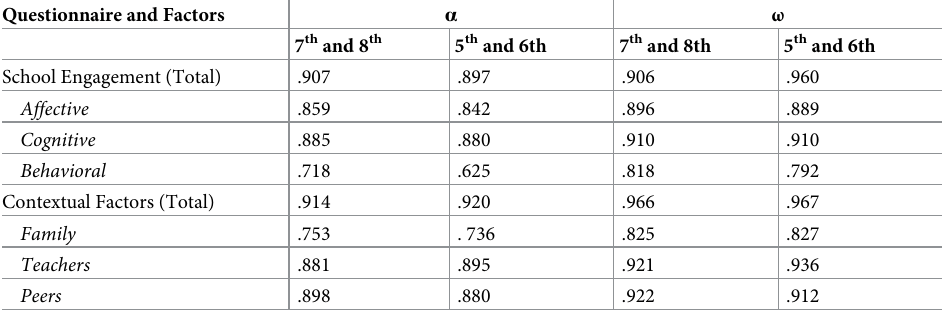
Table 3. Reliability of the questionnaires.